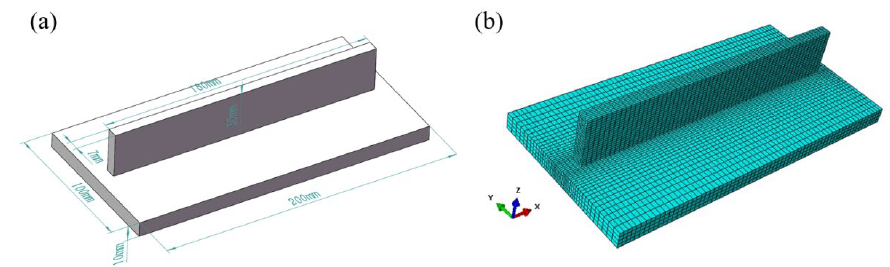
Figure 3. Geometric model. ( a ) Geometric model dimensions. ( b ) Finite element analysis divides the mesh.